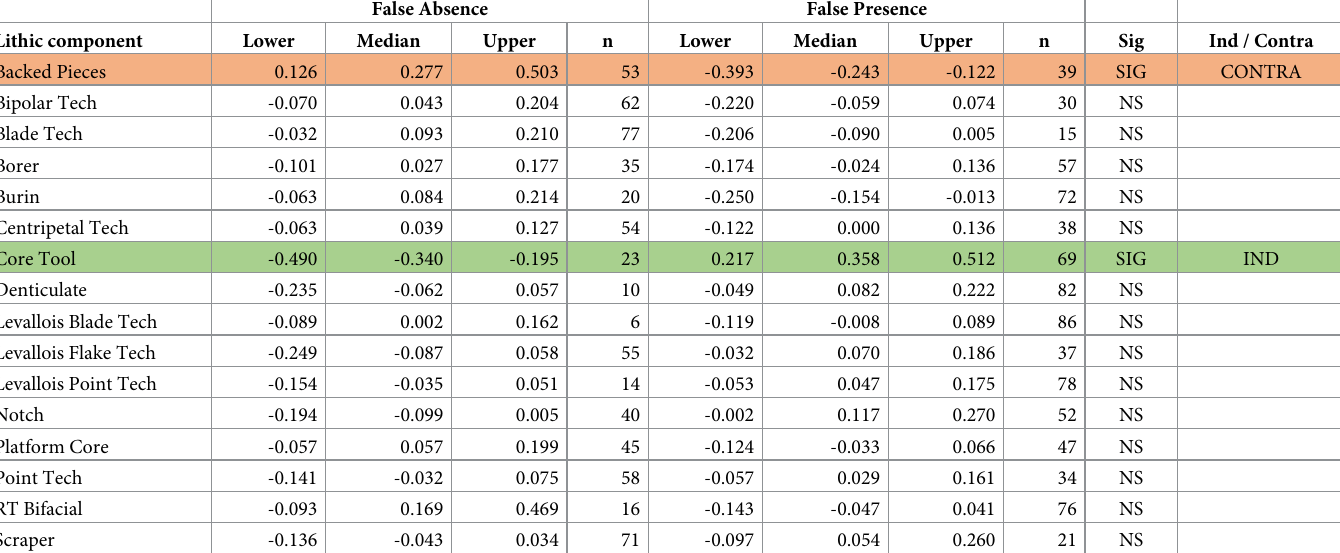
Table 6. Significant indicators of MIS5 MSA assemblages in the 3-way analysis. Details as per Table 4.